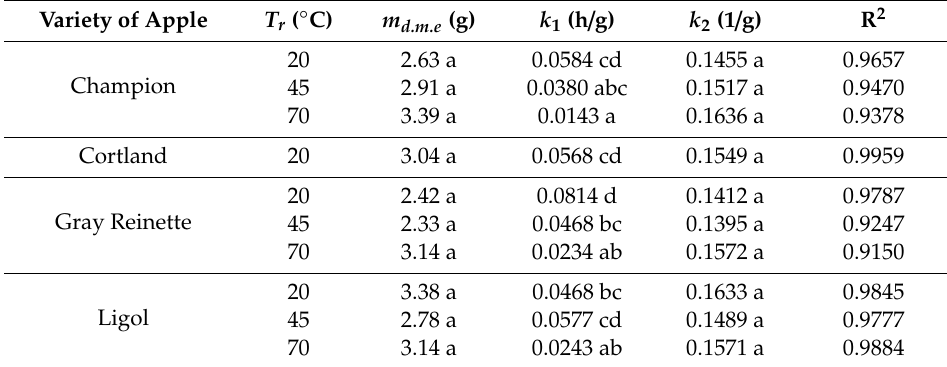
Table 3. Results of application of the Peleg model (Equations (10) and (11)) for approximating the dry matter loss during the rehydration of di ff erent varieties of dried apples. Variety of